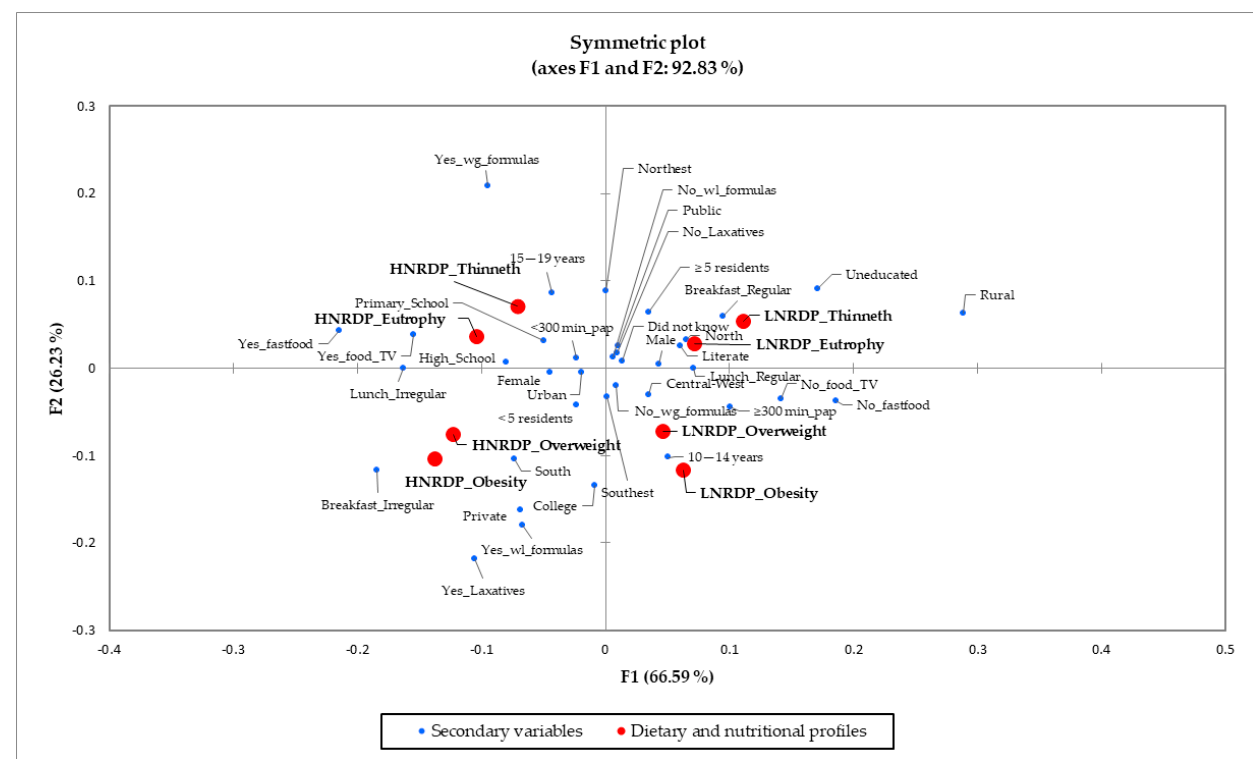
Figure 2. Correspondence analysis of Brazilian adolescents’ dietary and nutritional profiles and socio- economic and behavioral variables. National School Health Survey, 2015. Note: HNRDP_Thinneth: Higher nutritional risk dietary pattern and thinness; LNRDP_Thinneth: Lower nutritional risk dietary pattern and thinness; HNRDP_Eutrophy: Higher nutritional risk dietary pattern and eu- trophy; LNRDP_Eutrophy: Lower nutritional risk dietary pattern and eutrophy; HNRDP_Over- weight: Higher nutritional risk dietary pattern and overweight; LNRDP_Overweight: Lower nutri- tional risk dietary pattern and overweight; HNRDP_Obesity: Higher nutritional risk dietary pattern and obesity; LNRDP_Obesity: Lower nutritional risk dietary pattern and obesity; North, Northeast, Southeast, South, and Central-West: Geographic macro-region; Urban, Rural: School situation; Pub- lic, Private: School administrative dependence; Male, Female: Gender; 10–14 years, 15–19 years: Age;